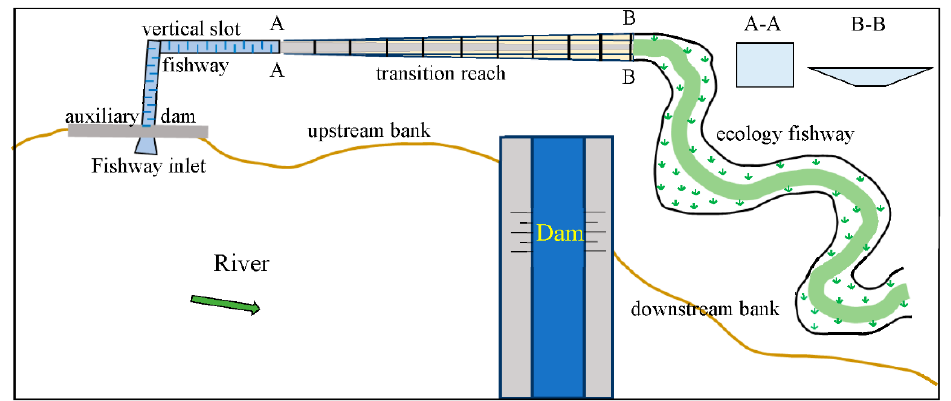
Figure 5. Layout sketch of the river and of a proposed fishway project in southern China. Only part of the fishway in the right bank is shown in the figure. There is an auxiliary dam built at the inlet of a natural flood diversion ditch upstream from the main dam. The fishway, designed as vertical slot structure, passes through the auxiliary dam and is connected to a meandering ecological fishway by a non-prismatic channel (transition reach). The beach and channel comprise the meandering ecological fishway.